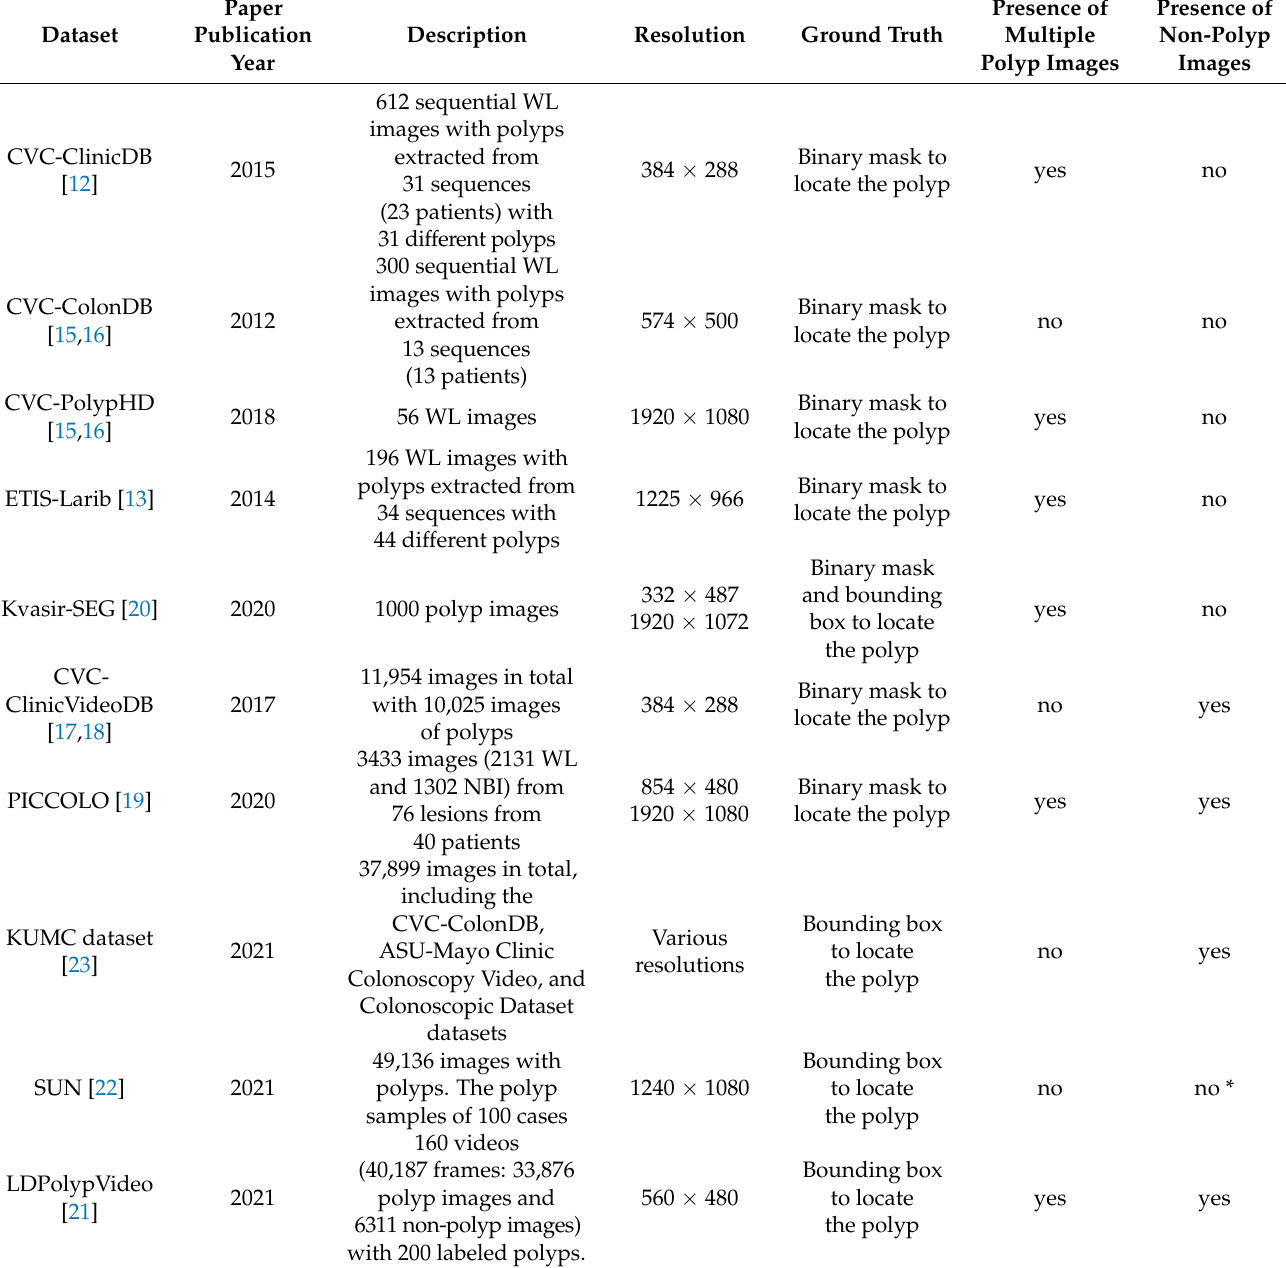
Table 1. Descriptions of the ten public colonoscopy image datasets for polyp